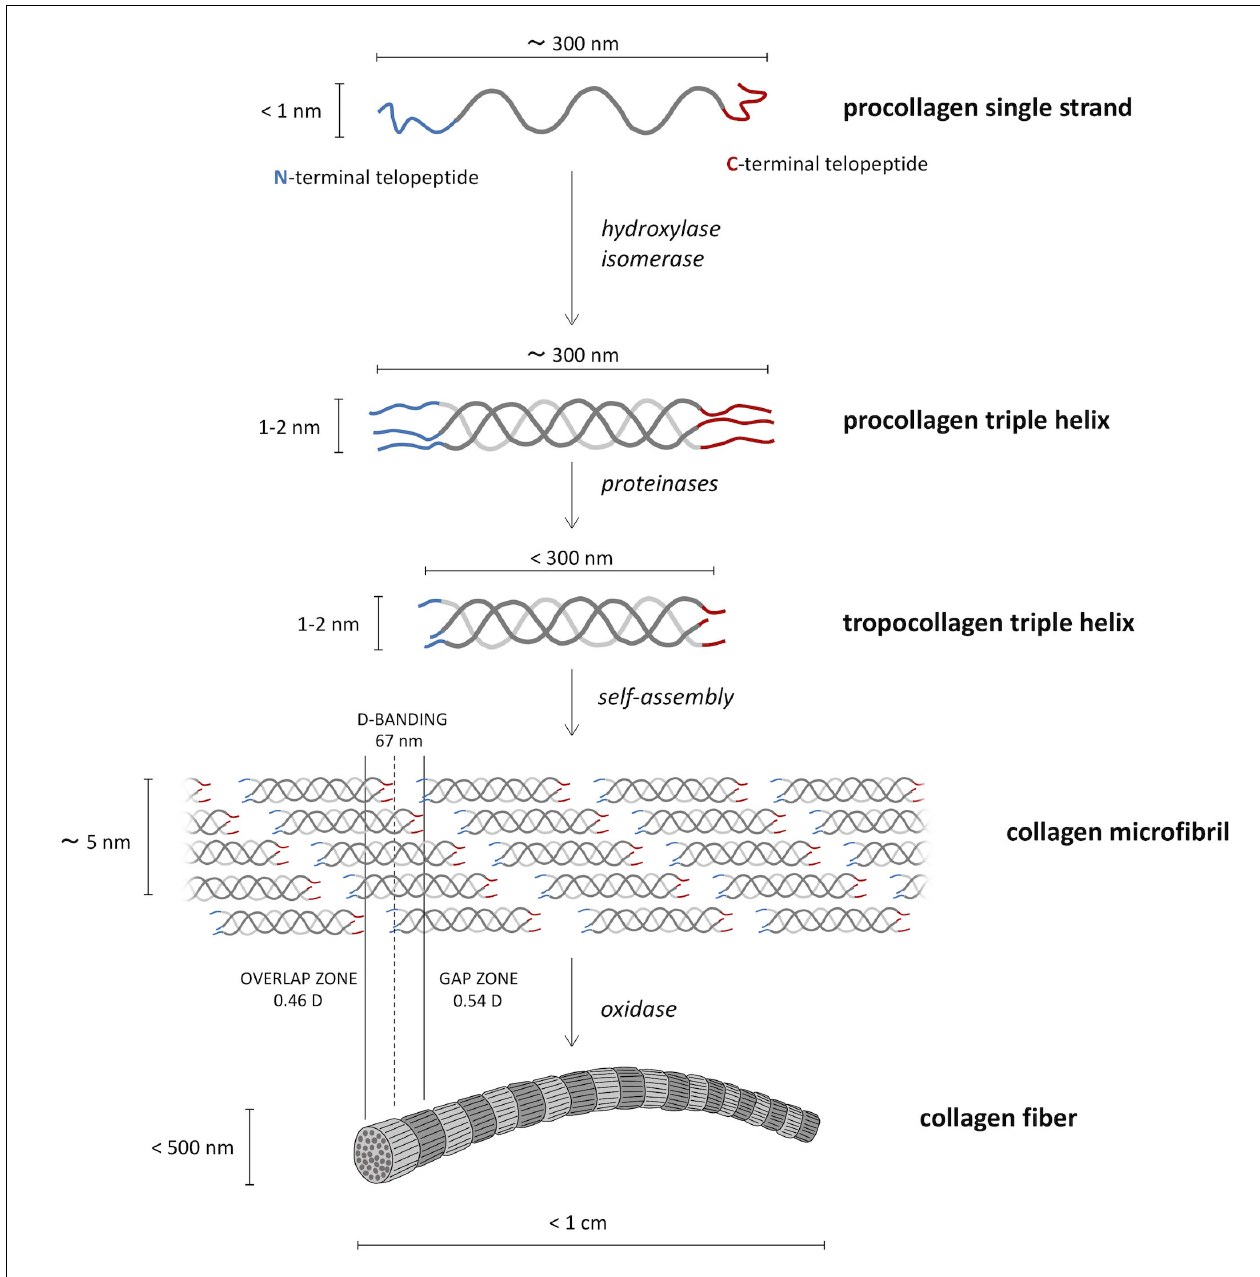
FIGURE 2 | Biosynthetic route from the molecular procollagen to collagen fibers. Three helical left-handed procollagen single strands form a right-handed triple helix of roughly 300 nm in length, named procollagen triple helix. The tropocollagen molecules, resulting from proteinases cut of N- and C-termini, go toward the supramolecular assembly in the so-called collagen microfibrils in the characteristic quarter-staggered form that causes the characteristic appearance of the collagen type I fibrils on the ultrastructural